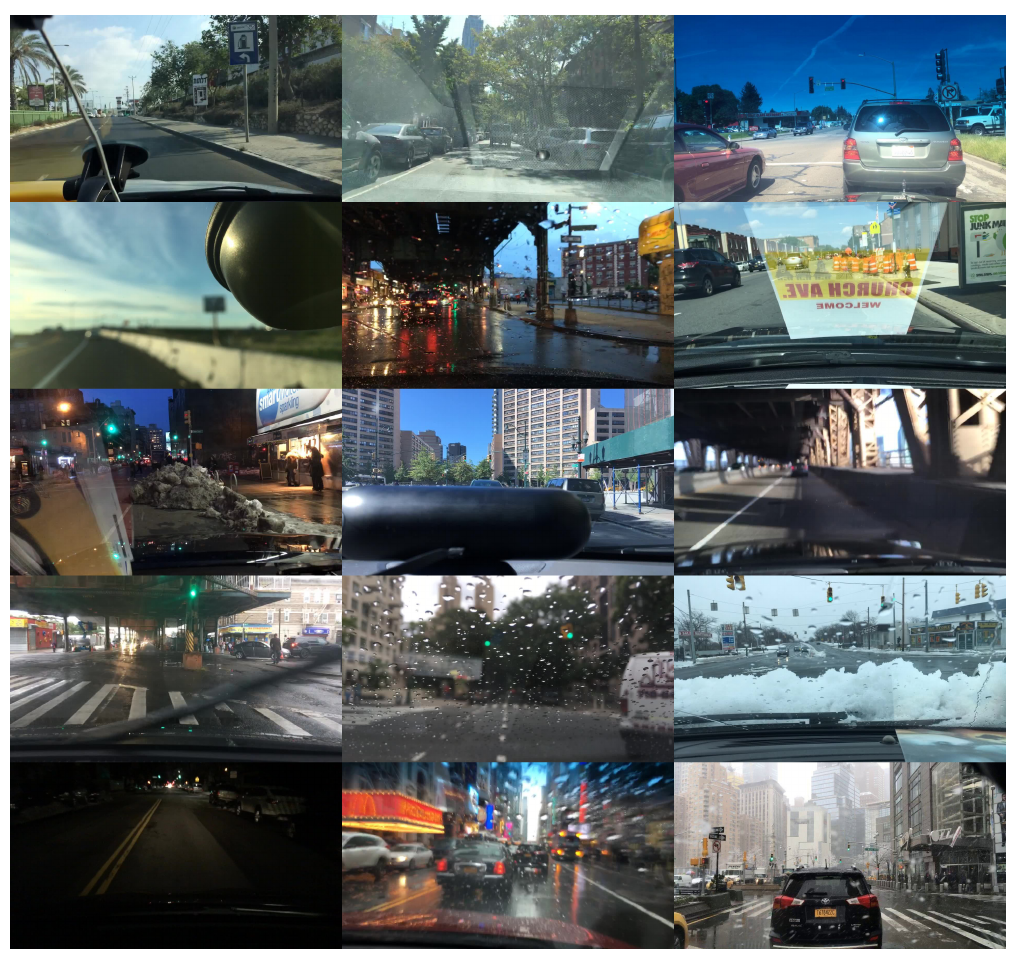
Figure 1. Image samples from BDD100K dataset, in which a great variability (occlusion, bad weather, glare, low light, low contrast, light reflection, blur ...) can be